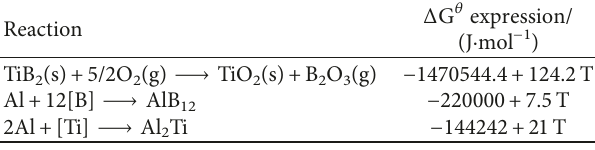
2 , Al 2 Ti, B 2 O 3 , and AlB 12 .